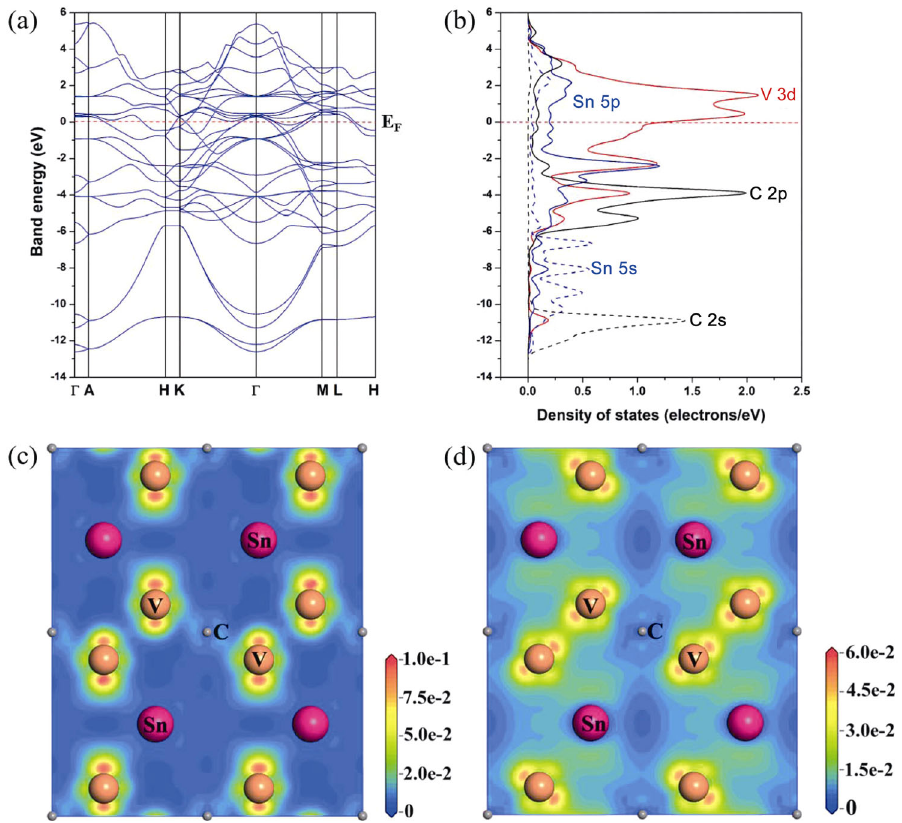
Fig. 7 (a) Band structure of V 2 SnC; (b) projected density of V, Sn, and C atom states; (c, d) electron density maps on (1120) plane of V 2 SnC near Fermi level. V 3d e g like, V 3d t 2g like, and Sn 5p z like orbitals can be seen in Figs. 7(c) and 7(d), respectively. A 2 × 2 × 1 cell is used and the unit is electron/Å 3 .